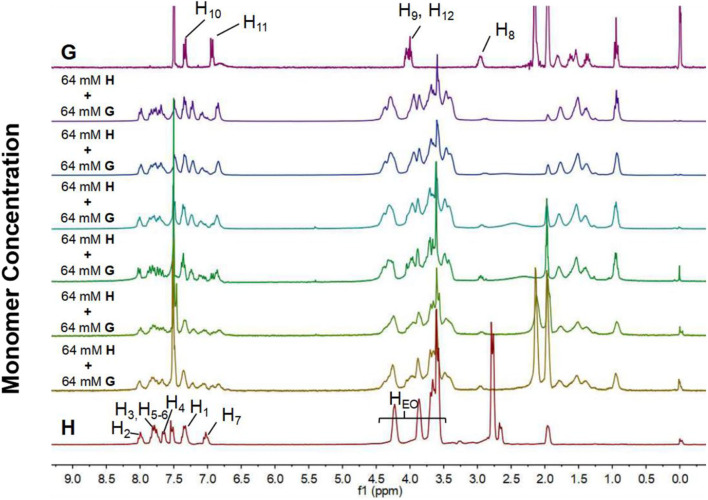
1H NMR spectra (300 MHz, CDCl3/CD3CN = 1/1, v/v, 298 K) of individual H and G, and mixtures of them at different monomer concentrations ([H]/[G] = 1/1).